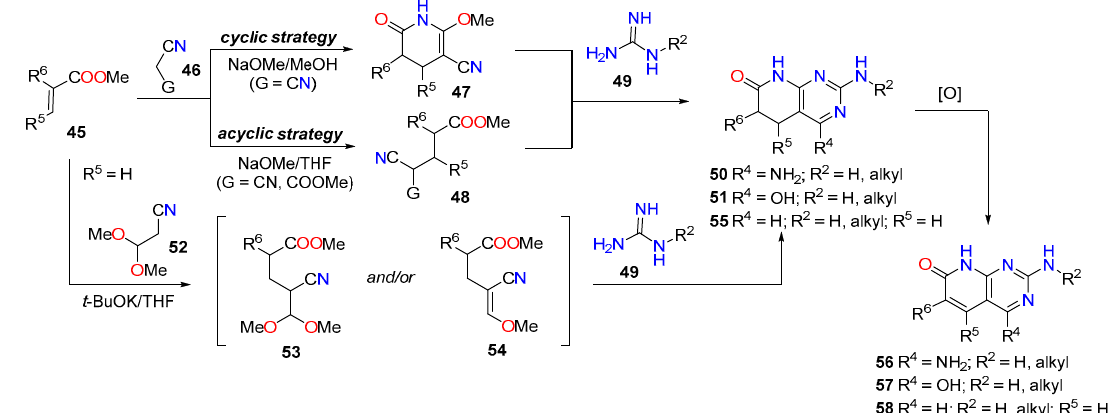
Figure 18. Synthesis of 5,6-dihydropyrido[2,3- d ]pyrimidin-7-(8 H )-ones and pyrido[2,3- d ]pyrimidin- 7-(8 H )-ones from α , β -unsaturated esters ( 45 ) .